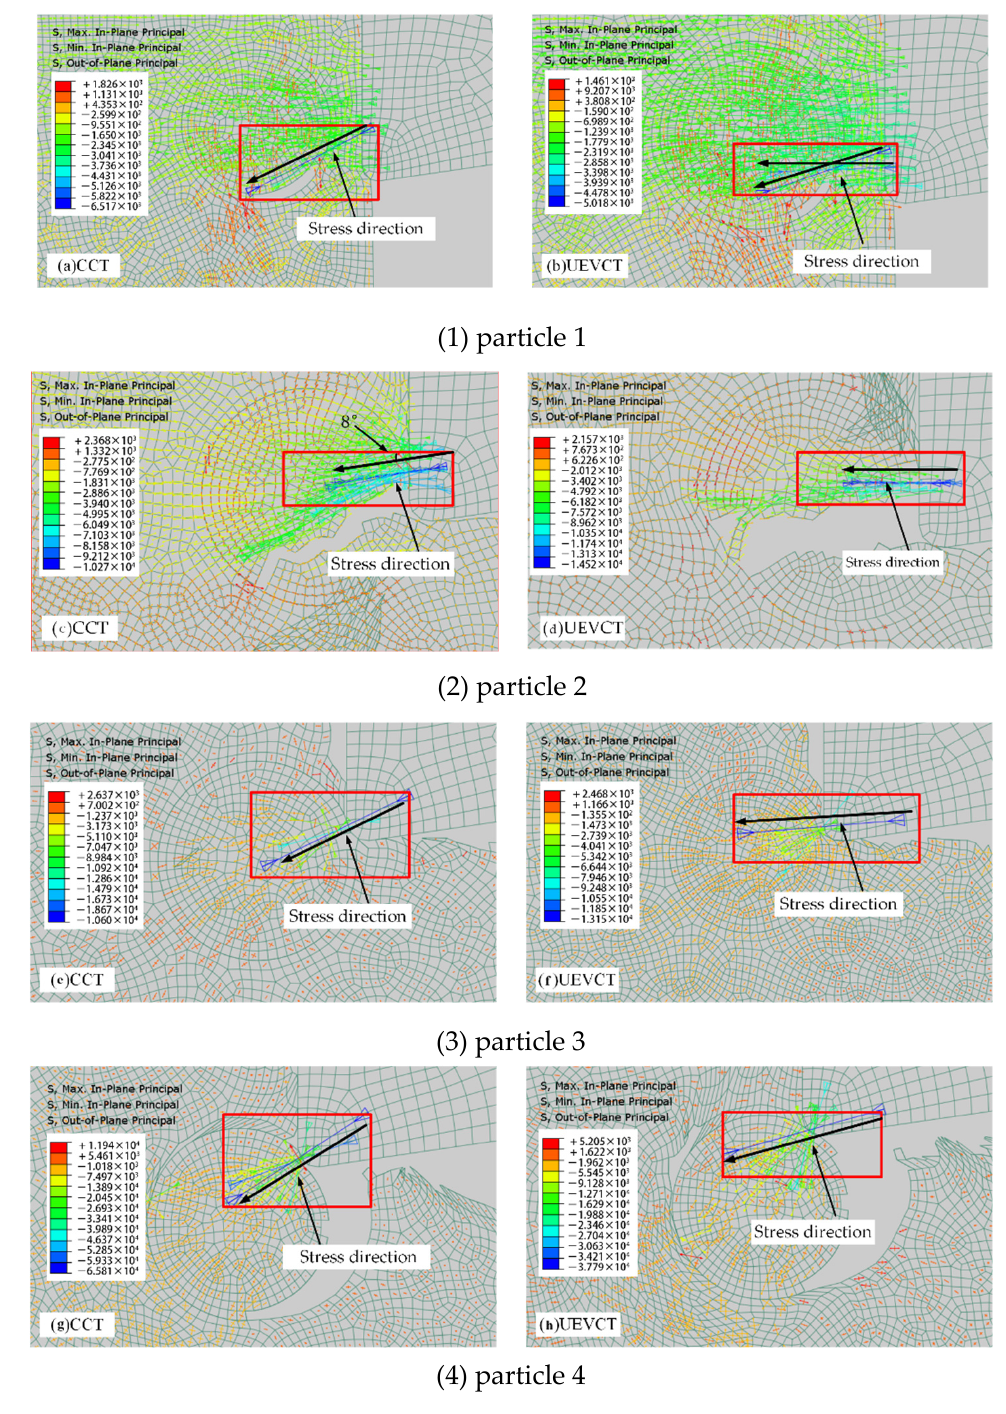
Figure 11. Force analysis of particles under two cutting modes. As shown in the picture, ( a , c , e , g ) is the stress direction of the particle during conventional cutting.( b , d , f , h ) is the stress direction of the particle during ultrasonic elliptical vibration cutting.